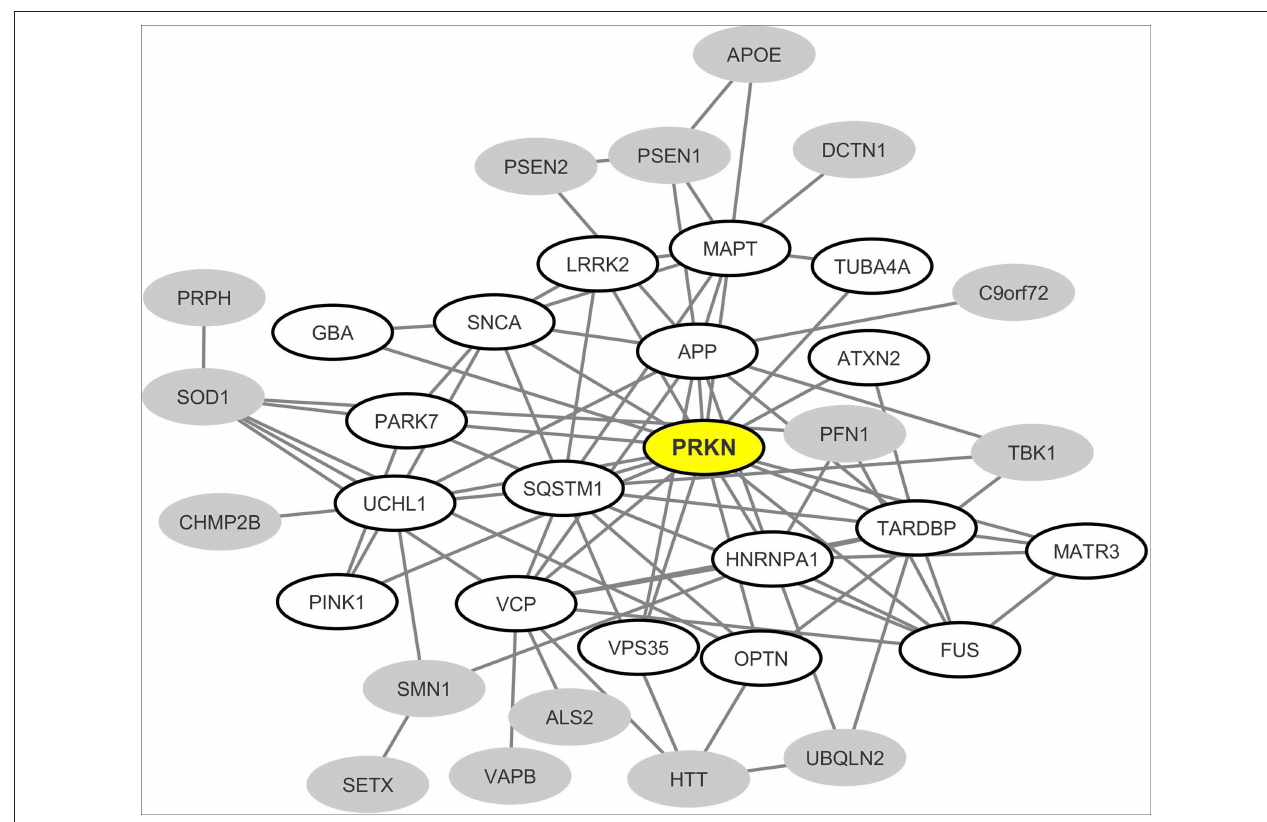
FIGURE 2 | Mapping of the protein-protein interaction network linking common neurodegeneration-associated proteins irrespective of the cell type considered. A survey of the human proteome was performed by querying the protein-protein interaction database BioGRID (38). Each node represents a protein indicated by the corresponding gene symbol and each edge represents an experimentally-demonstrated protein-protein interaction. In this network, the “PRKN” (Parkin) node, highlighted in yellow, exhibits the highest degree (i.e., the highest number of direct interactors). White nodes correspond to the first-shell partners of PRKN. Gray nodes are not direct interactors of